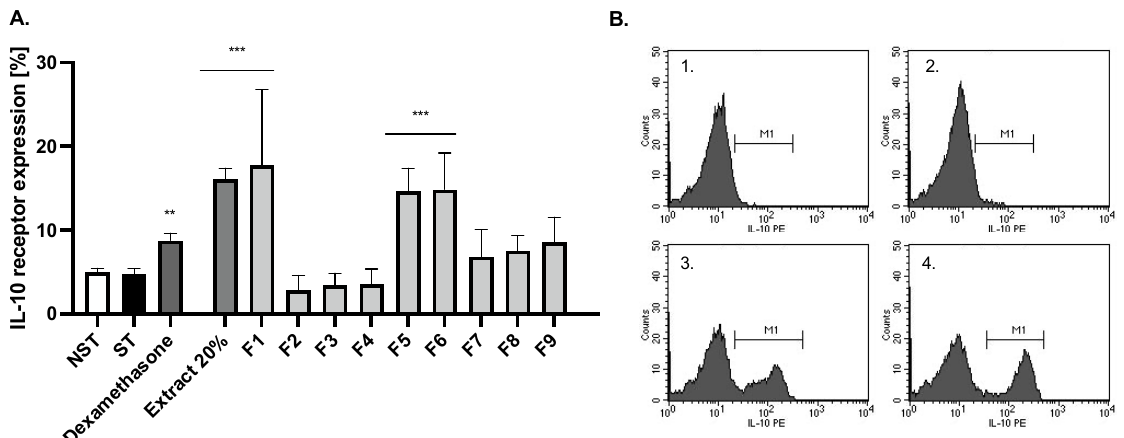
Figure 4. The influence of 20% methanolic extracts on IL-10 receptor expression by LPS-stimulated monocytes/macrophages ( A ). Representative flow cytometry images of IL-10R expression on the surface of monocytes/macrophages ( B ) in non-stimulated control ( 1 .), LPS-stimulated control ( 2 .), F4 50% MeOH ( 3 .), F6 50% MeOH ( 4 .) Non-stimulated cells (NST), LPS-stimulated (ST) monocytes/macrophages and LPS-stimulated monocytes/macrophages treated with 50 μ g/mL of selected fractions. Dexamethasone (20 μ M) was used as positive control. Data are expressed as mean ± SEM (three separate experiments performed on monocytes/macrophages isolated from independent donors). Statistical significance: ** p < 0.01,*** p < 0.001 versus stimulated control.